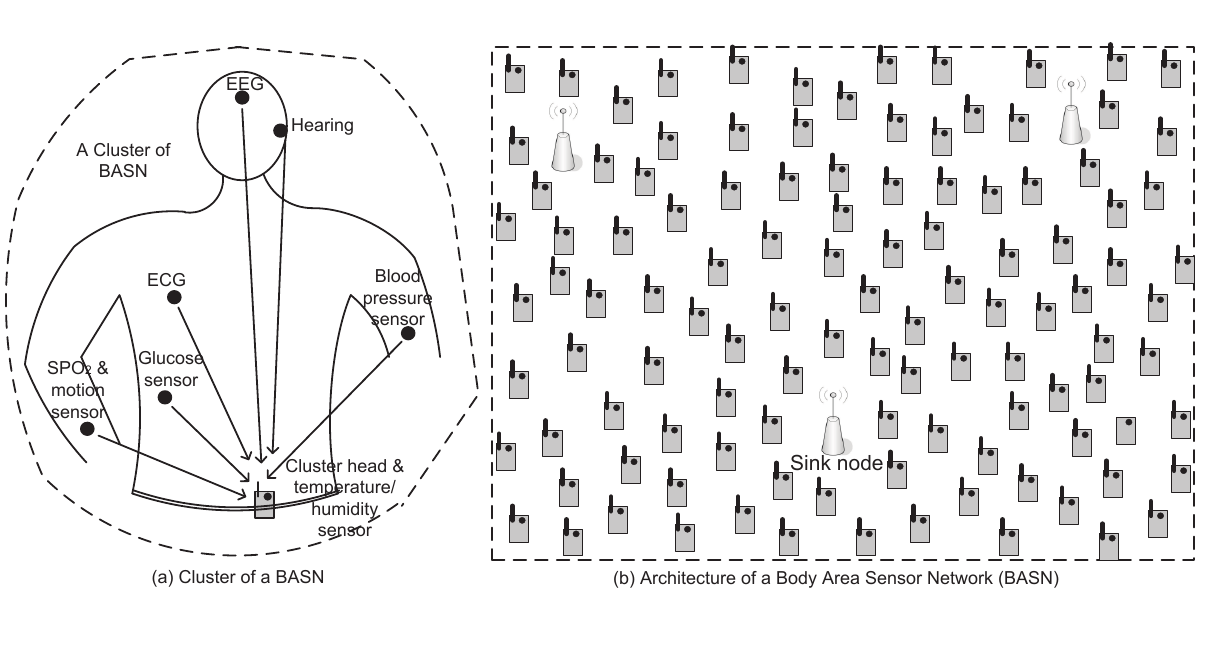
Figure 1. Body Sensor Network